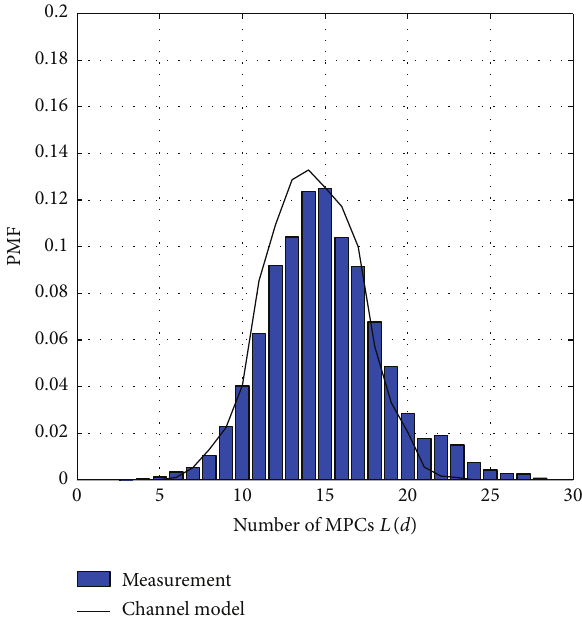
Figure 19: NLoS bias comparison between measurement based estimation and channel model based simulation for Scenario-1.